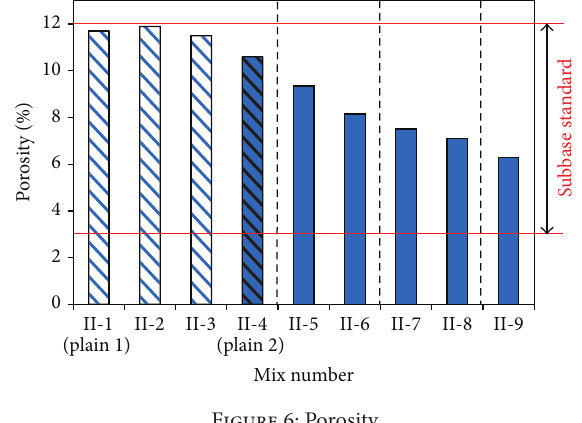
Figure 6: Porosity.